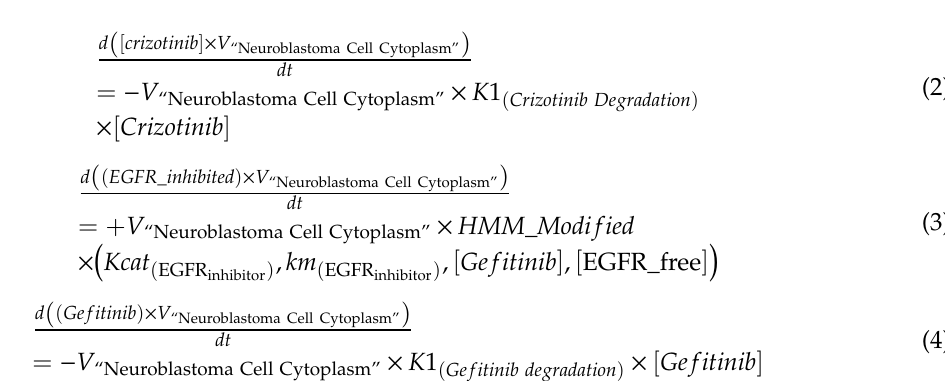
Figure 4. Expression of PD-L1 in a neuroblastoma cell line with and without ALK mutation ( A ). ( B ) Expression of PD-L1 after treatment with 1.4 × 10 −3 mM crizotinib therapy ( C ), 3 × 10 −3 mM gefitinib therapy ( D ) and a combination of the two inhibitors ( E ). The simulation was conducted from 0 to 2 × 10 5 s., using the deterministic (LSODA) method. All concentrations are in mmol/mL. Comparison of the cumulative area under the curves (AUCs) of PD-L1 expression without therapy and with different therapy regimens ( F ).